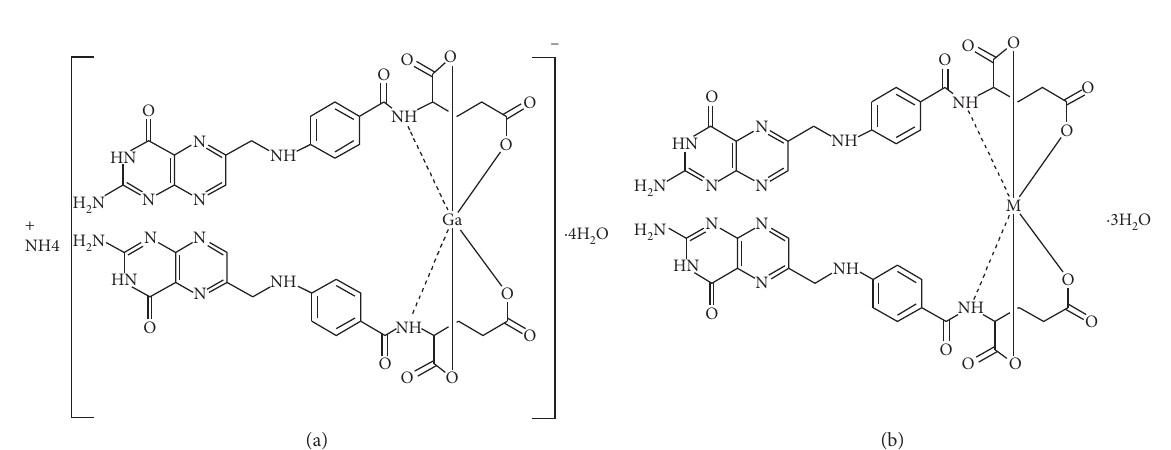
Figure 5: (a) Speculated structure of the Ga(III) folate complex; (b) speculated structures of Ge(IV) and Hf(IV) folate